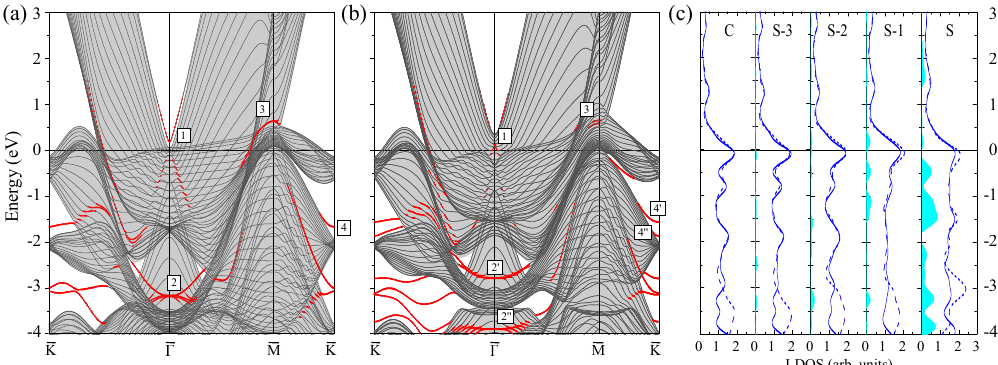
Figure 1. The electronic structure of the Pt(111) surface calculated for the 23 monolayer thick slab without ( a ) and with ( b ) spin–orbit interaction. The surface states and resonances are indicated by red dots. The surface states discussed in the text are labeled by symbols. In ( a ) and ( b ), the continuum of the projected bulk electronic states is indicated by the grey color. In ( c ), the layer density of states (LDOS) is shown for the top four (labeling of atomic layers starts from the surface (S) one) and the central (C) atomic layers. Solid (dashed) lines show LDOS obtained from the calculation with (without) spin-orbit coupling. Blue regions show the excess of LDOS in a given layer in comparison with the bulk